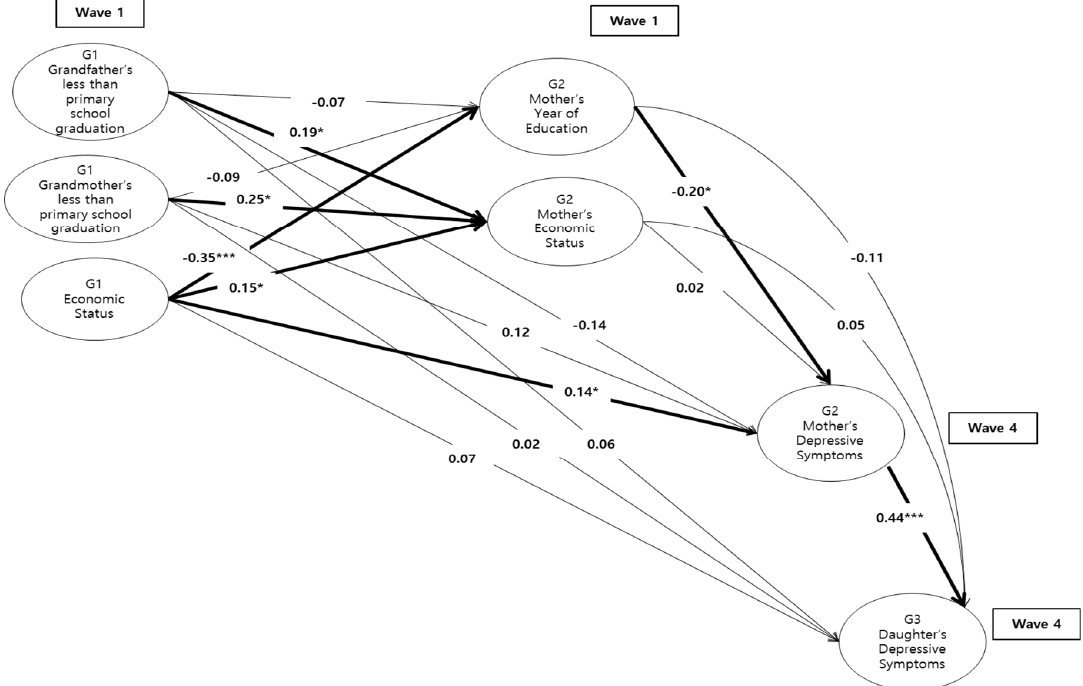
Figure 3. Standardized results of intergenerational model by mother’s depressive symptoms (G2), Table 2 and economic status (G2) as mediators. The model above controls mother’s (G2) and daughter’s (G3) demographic factors such as mother’s age, mother’s living with spouse, mother’s family income,